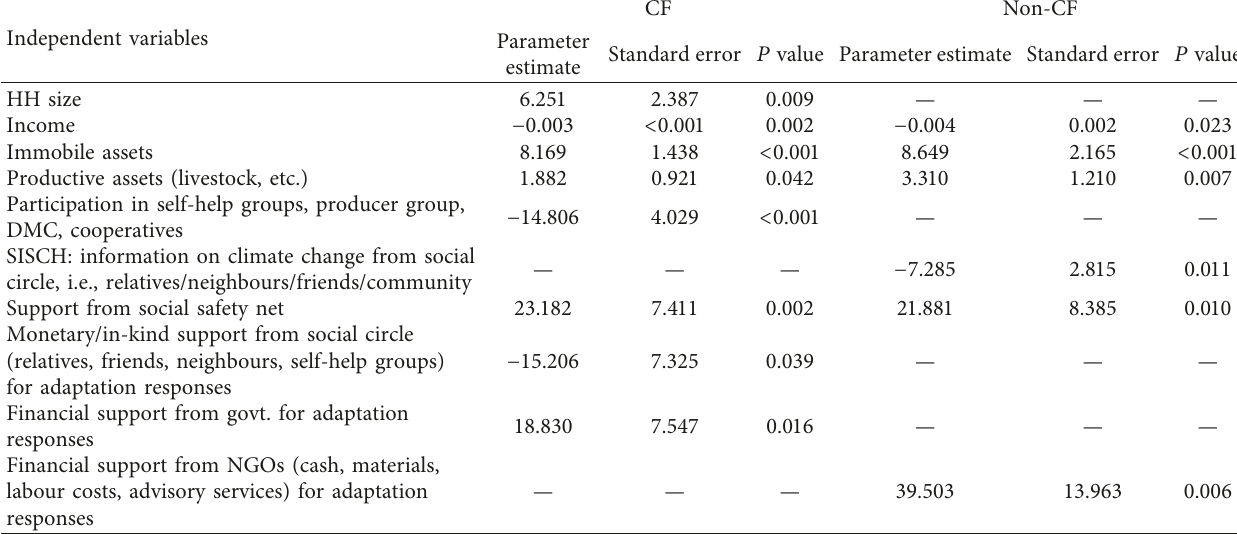
Table 10: Multiple linear regression results for CF and non-CF models for overall risk